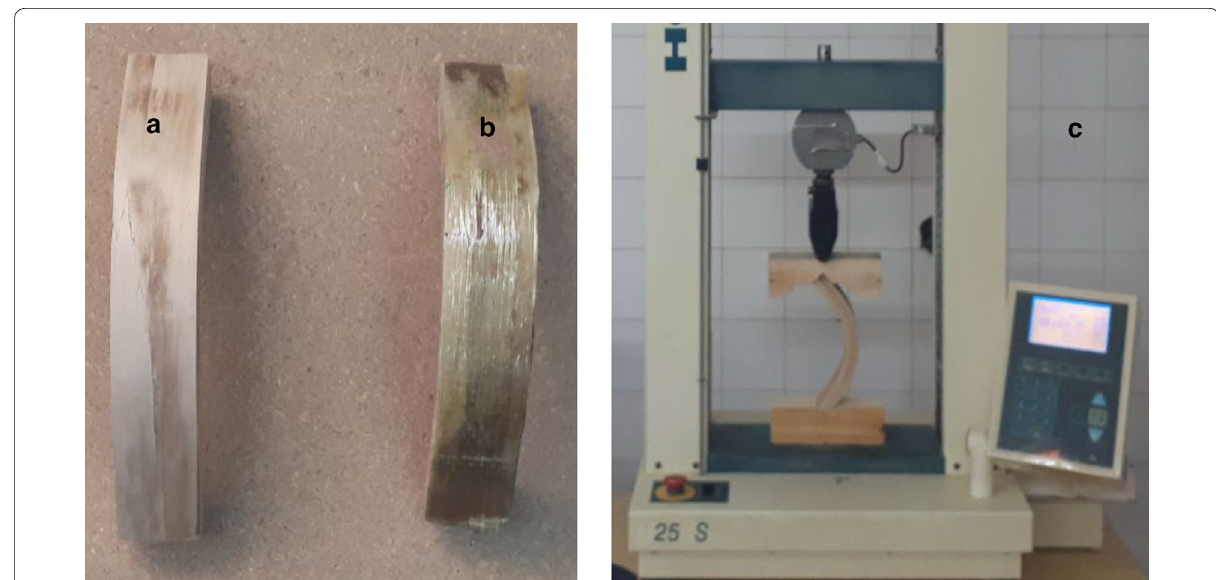
Fig. 3 a Primary‑curved sample, b rehabilitated‑curved sample with GFRP), and c the schematic illustration of the compression test